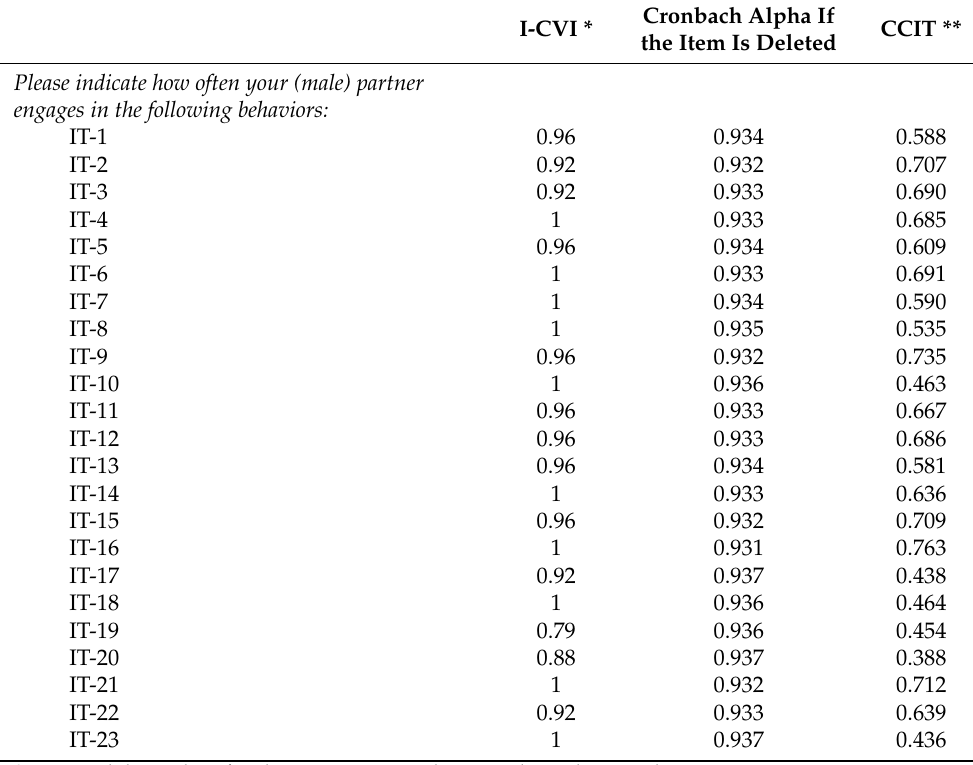
Table 5. Content validity index and reliability analysis of the 23-item Q-IVAW ( N =